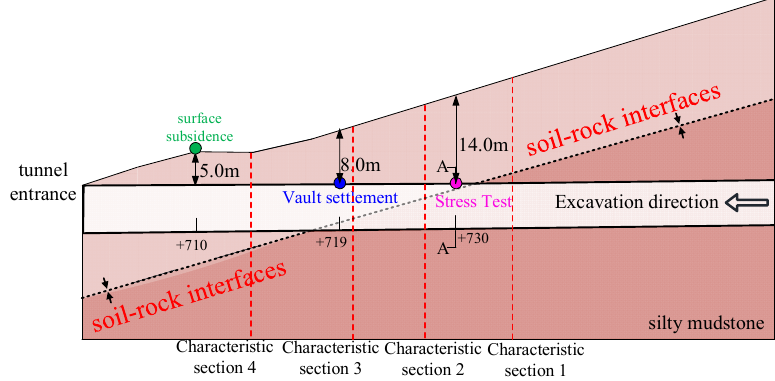
Figure 2. Longitudinal view of the soil-rock interface at the tunnel